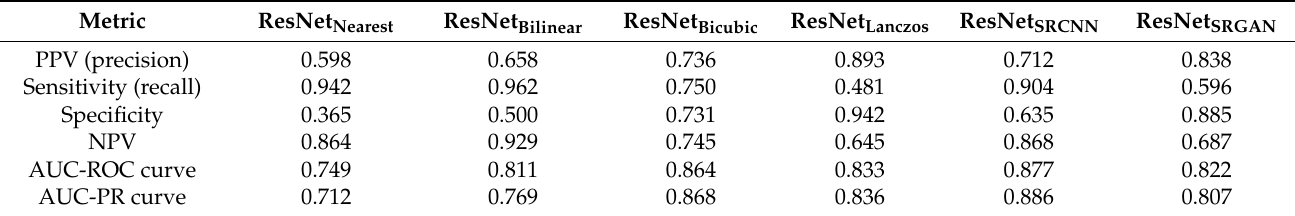
Table 6. Test results for each ResNet model.